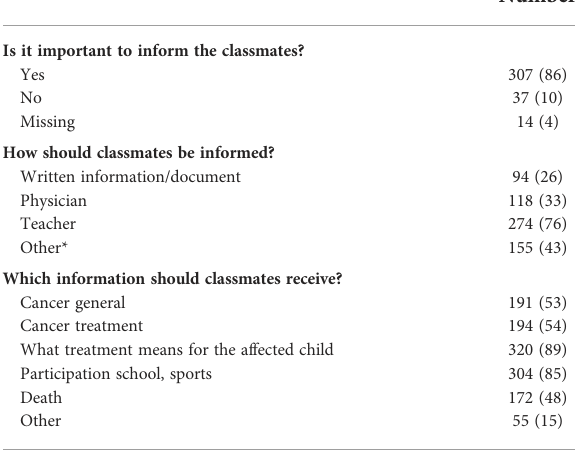
TABLE 4 Teachers ’ perception if/how to inform classmates